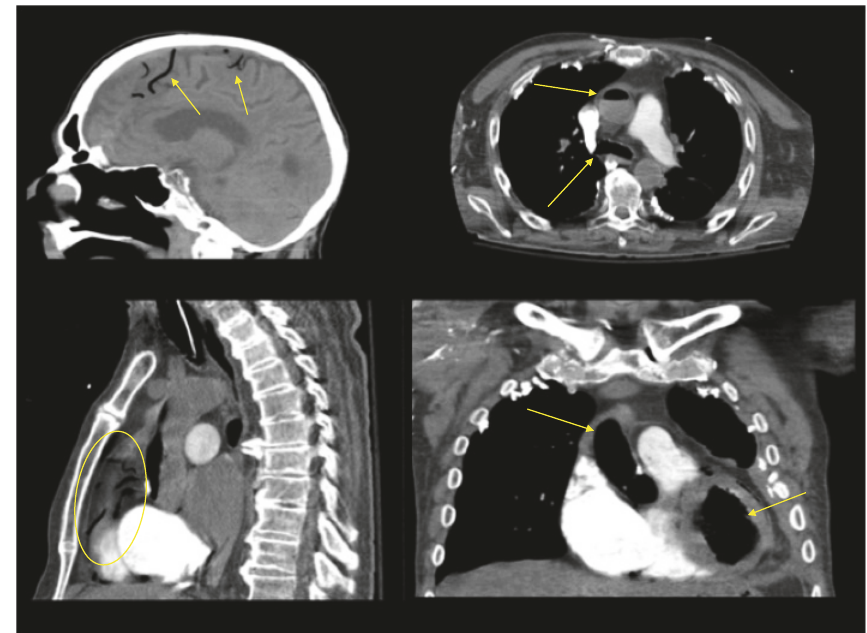
Figure 4: (a): Air within the cortical vessels (arrows); (b) air within the ascending and thoracic descending aorta (arrows); (c) air within the coronary arteries (circle); (d) air within the aortic arch and the left